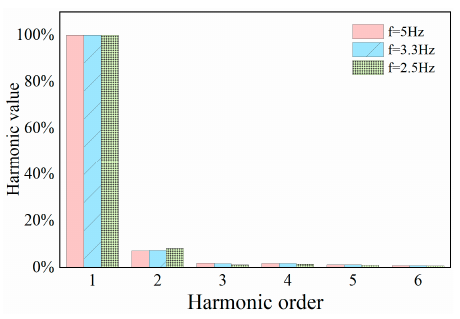
Figure 13. EMF curve of PMLG under different periods.